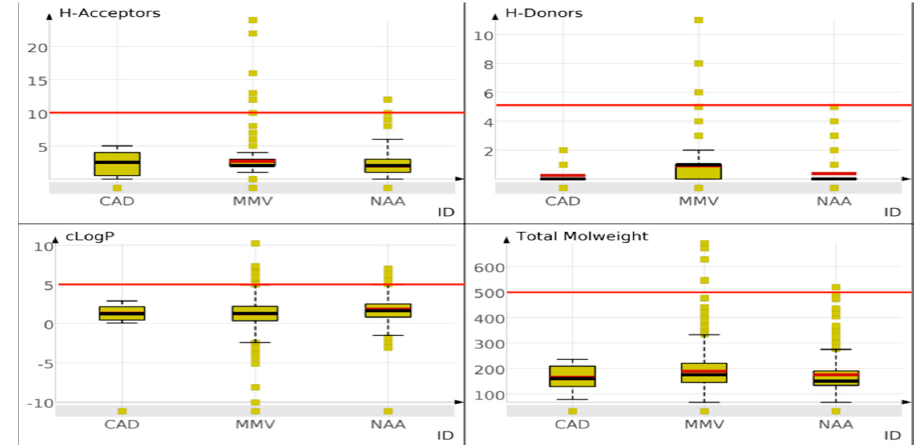
Figure 7. Drug-like properties of scaffolds from the datasets analysed. Properties like number of hydrogen bond donors and acceptors, cLogP and molecular weight of scaffolds from CRAD, NAA and MMV were assessed.